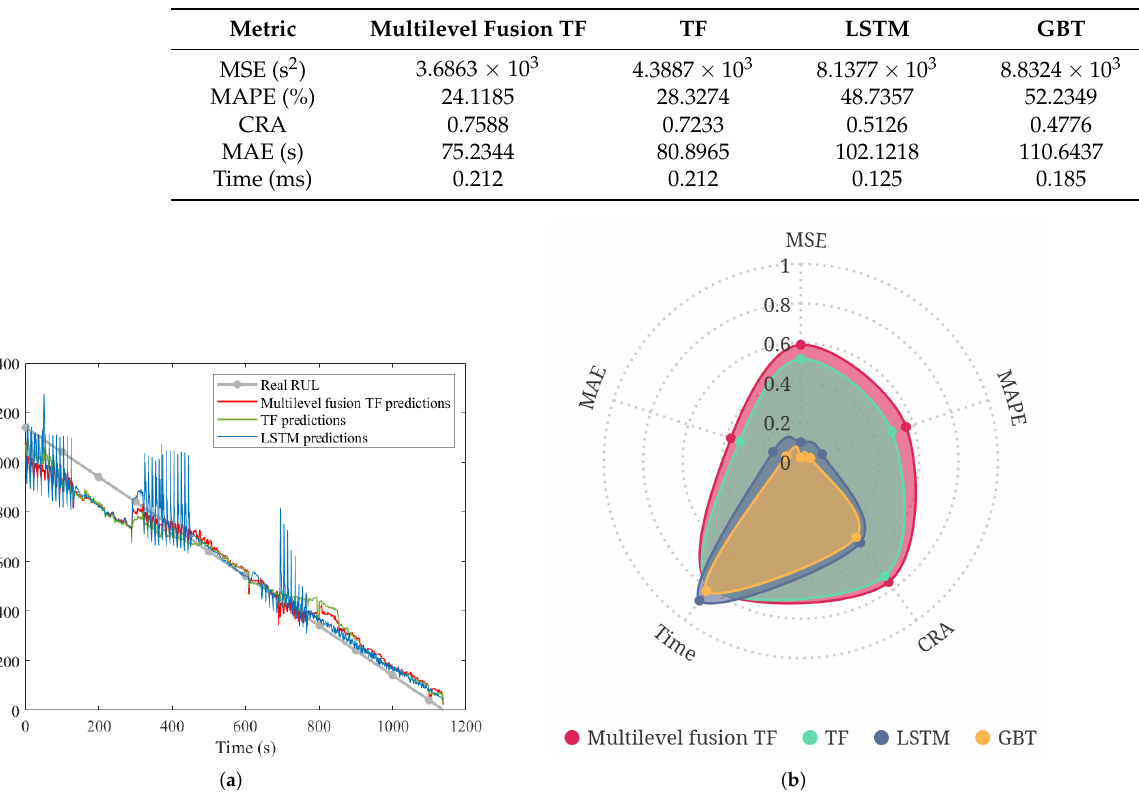
Figure 8. The one-step prediction results. ( a ) Comparative results of RUL predictions. ( b ) The 5-dimensional radar chart for the performance comparison of prediction methods. The performance depicted in the radar chart ranges from 0 to 1 (from low to